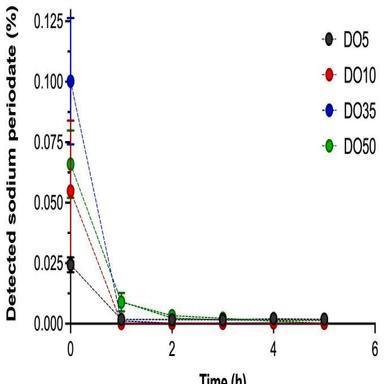
Oxidation of alginates with different DOs (i.e.DO5 (black), DO10 (red), DO35 (blue) and DO50 (green). The detected sodium periodate is expressed as the percentage of measured value at each time point against the initial concentration. Values at t0 are measured 1–2 min after addition of sodium periodate to alginate solution. Data are presented as mean ± st.dev. of n = 3, N = 3 independent measurements. (For interpretation of the references to colour in this figure legend, the reader is referred to the web ve